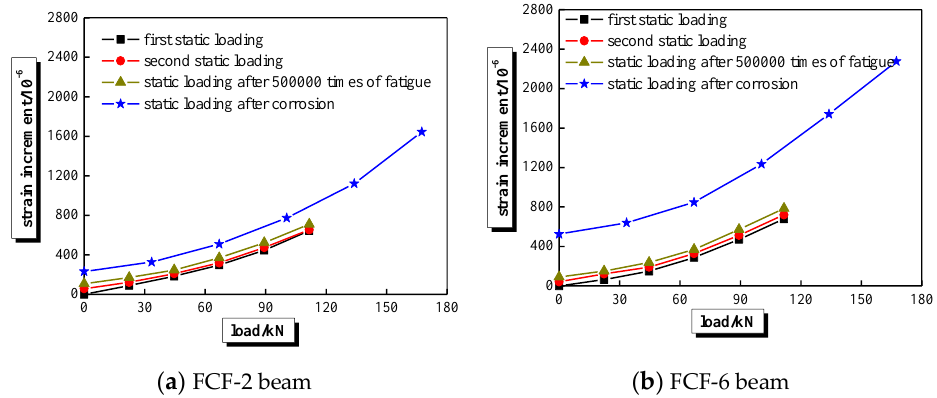
Figure 8. Strain-load curves of steel strands.